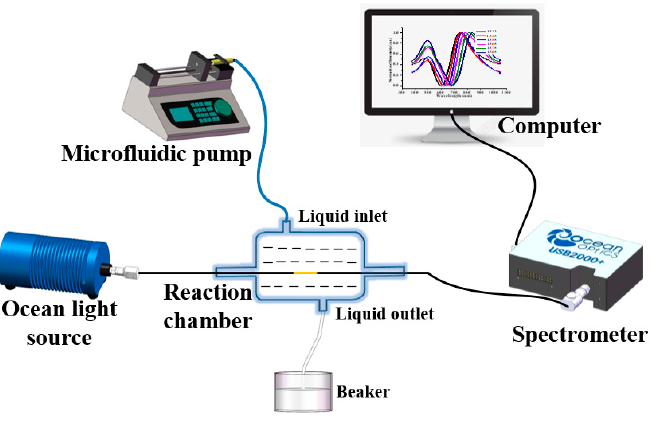
Figure 6. GDF11 concentration testing device of twisted fiber SPR sensing probe.